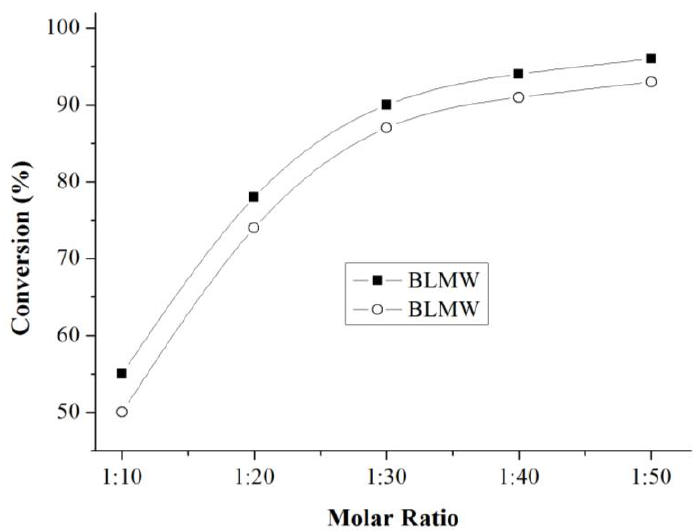
Figure 9. Effect of DDPO:EtOH molar ratio on the % conversion during DDPO esterification with ethanol using catalyst. Reaction conditions: reaction temperature: 160 °C, catalyst amount: 5.0%, and reaction time: 2 h.